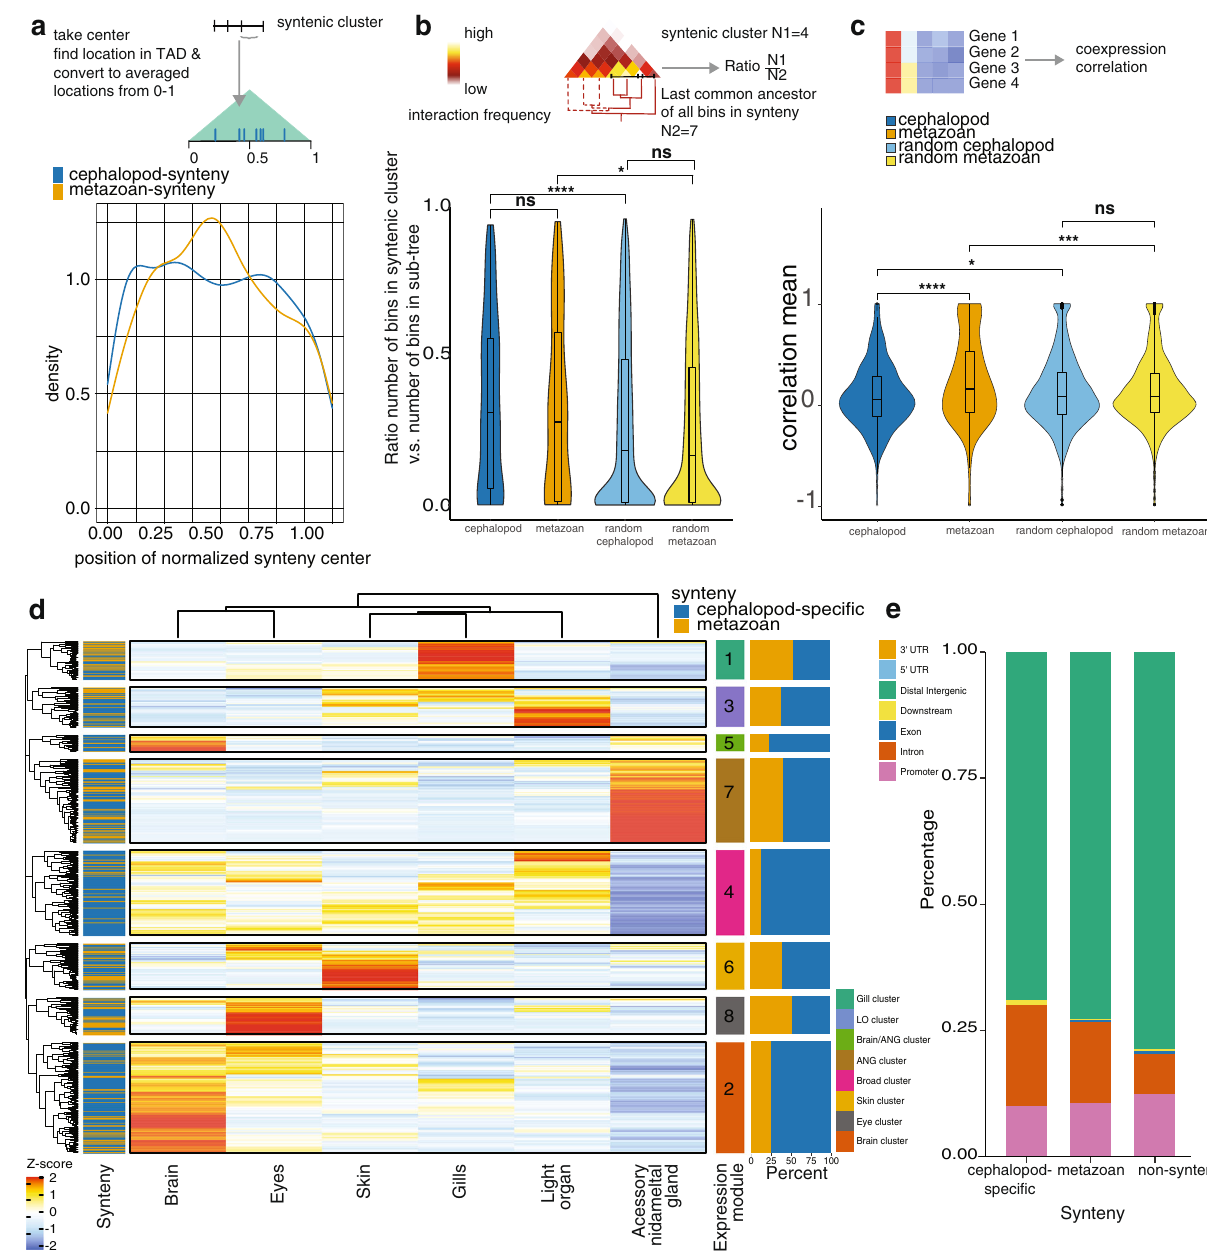
similar to previous fi ndings for ancient metazoan microsynteny 8 . A conserved metazoan microsyntenies in O. bimaculoides